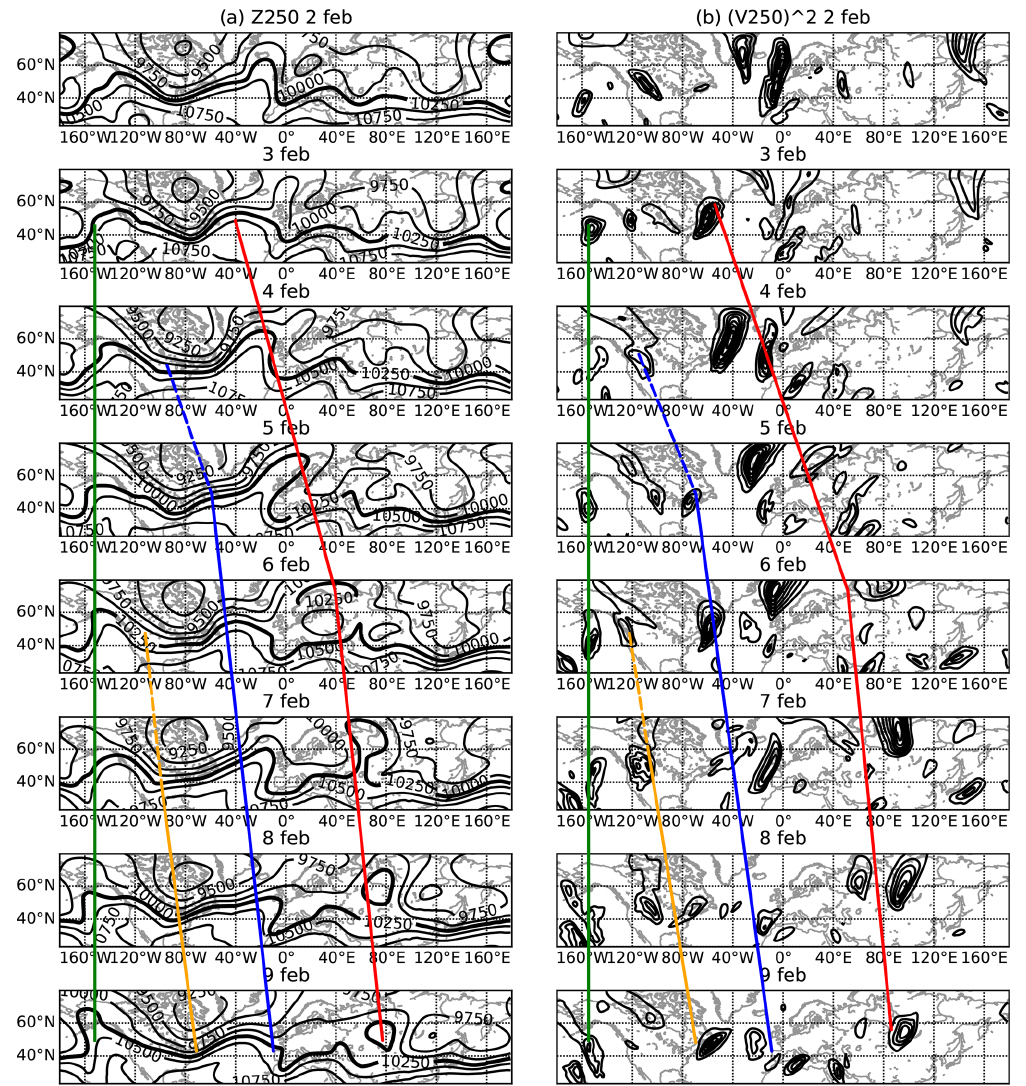
Figure 9. Time sequence of (a) ERA-I 250hPa geopotential height observed from 2 (top) to 9 (bottom) February 2018 over a domain (20– 70 ◦ N). The thick contour corresponds to 10250m. (b) ERA-I 250hPa meridional velocity squared; contour intervals are 800m 2 s − 2 . The coloured lines track the movement of the ridges and troughs (a) and corresponding maxima of meridional velocity squared (b) , and they suggest the propagation of wave